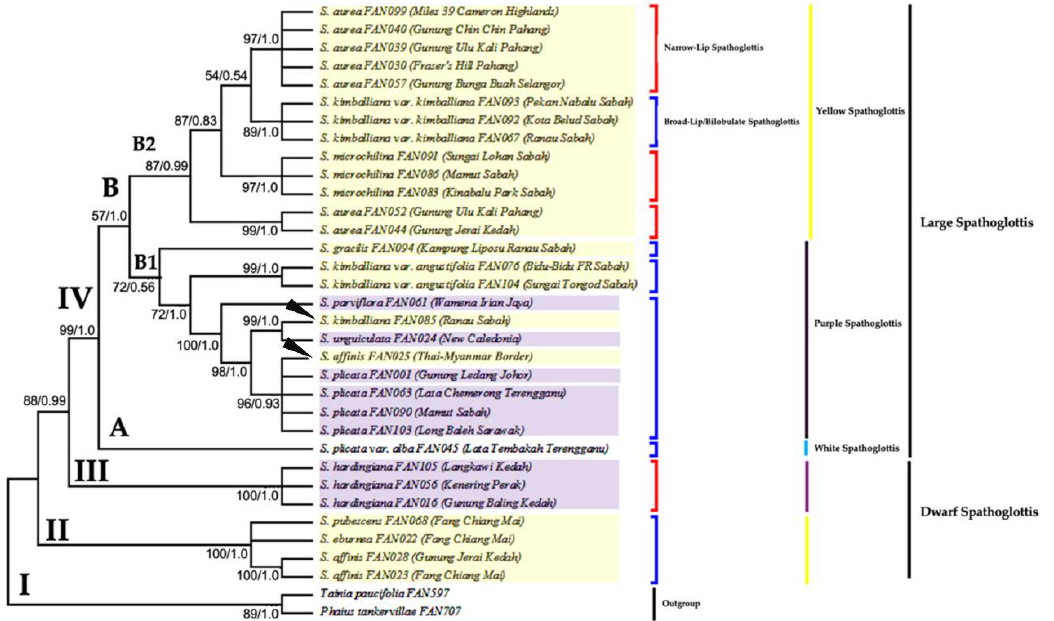
Figure 2. The combined majority-rule consensus tree results from ML analysis and optimal tree results from Bayesian analysis generated from the ITS sequence dataset. Number below branches are bootstrap percentages ≥ 50 and probability values ≥ 0.5 (BS/PP). Clade II–IV shows the ingroups of genus Spathoglottis ; Clade I indicates outgroup. Clade II and III holds the Dwarf Spathoglottis species, while Clade IV (A and B) consists of the Large Spathoglottis species. Clade B is further separated into subclades B1 and B2; each holds the Large Purple and Large Yellow Spathoglottis spe- cies group, respectively. Taxa highlighted in yellow box are the yellow flower Spathoglottis while purple box comprises of flowers in different shades of purple. Groupings of taxa were also based on the shape of the labellum; either narrow or broad/bilobulate.